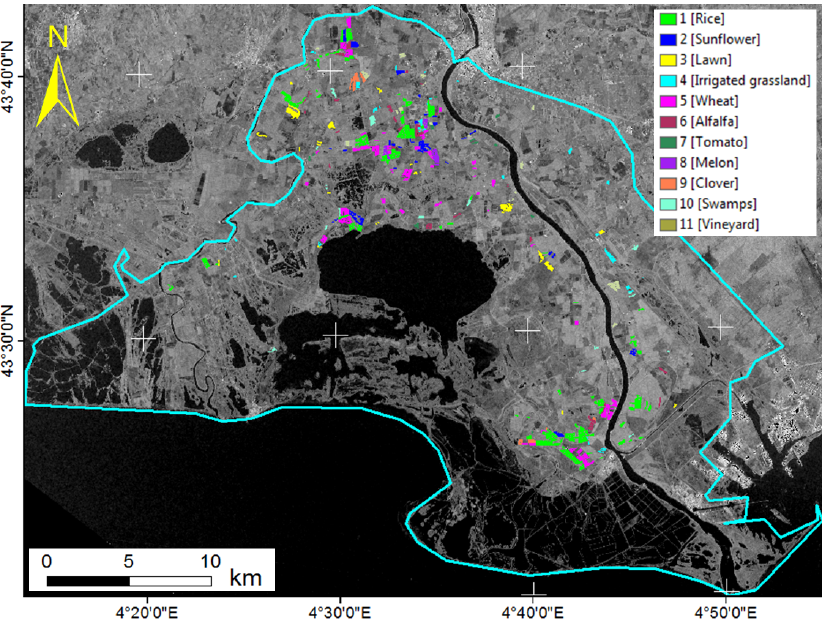
Figure 1. Camargue study area. Colored polygons represent 921 reference plots location. The study area is limited by the cyan